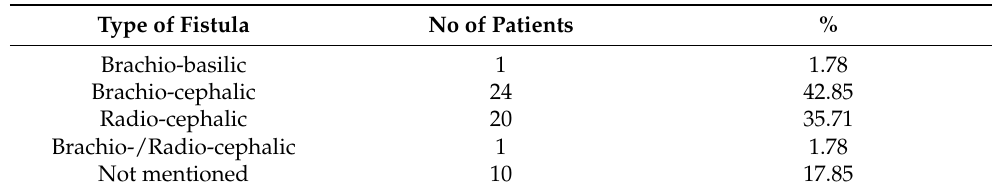
Table 1. Distribution of patients with respect to AVF type. Type of